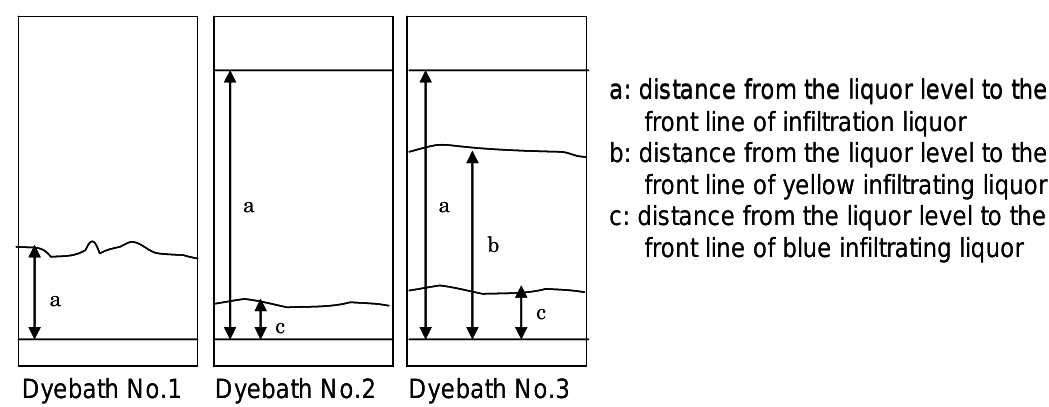
Figure 9. Dye penetration using filter paper